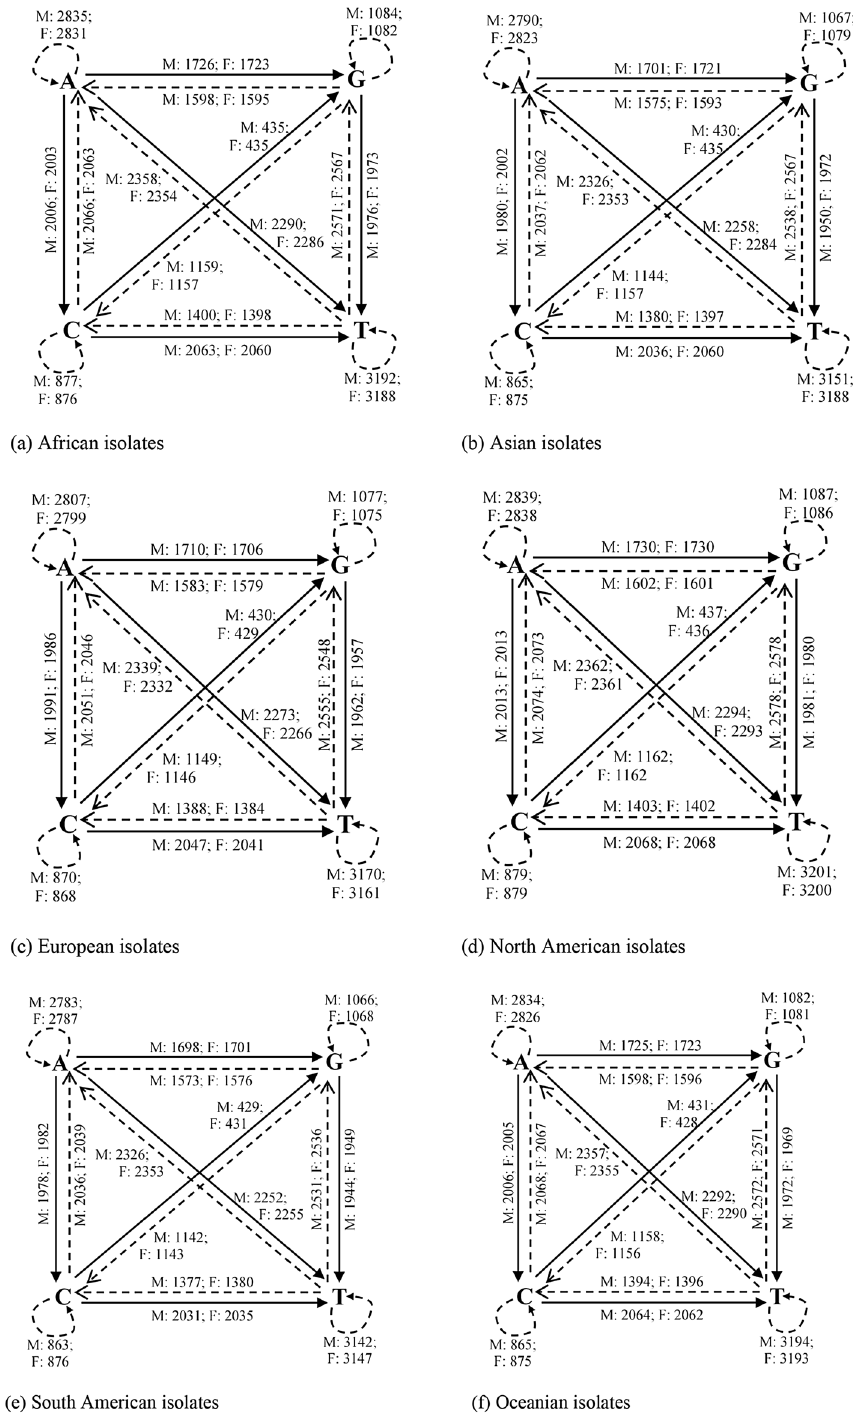
Figure 2. Base pair transitions in SARS-CoV-2 genomes for male and female isolates. Thick arrows indicate transition, while dotted arrows represent transversion. Looped (dotted) arrows represent same base transition. Inscriptions on/near the arrows represent transition/transversion frequencies for male and female